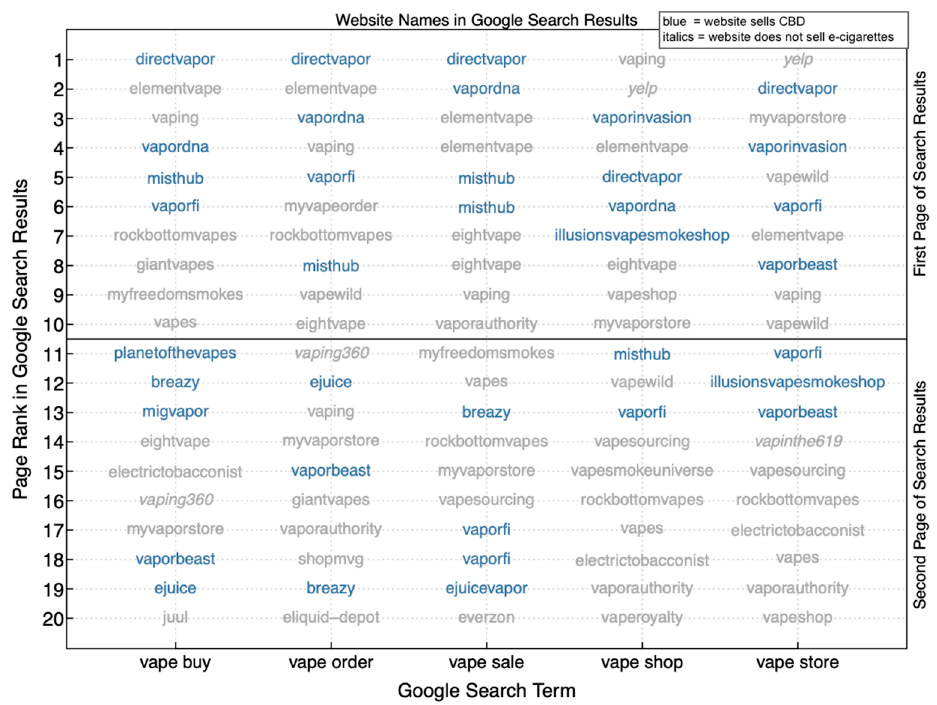
Figure 1. Vape shops who sold CBD products featured prominently in the first two pages of Google search results indicative of shopping for vaping products, June 2020; Notes: Blue text indicates visitors could purchase CBD products from the webpage. Three websites (indicated in italics: Yelp, vaping360, & vapinthe619) did not allow visitors to mail-order e-cigarettes. CBD = Cannabidiol.